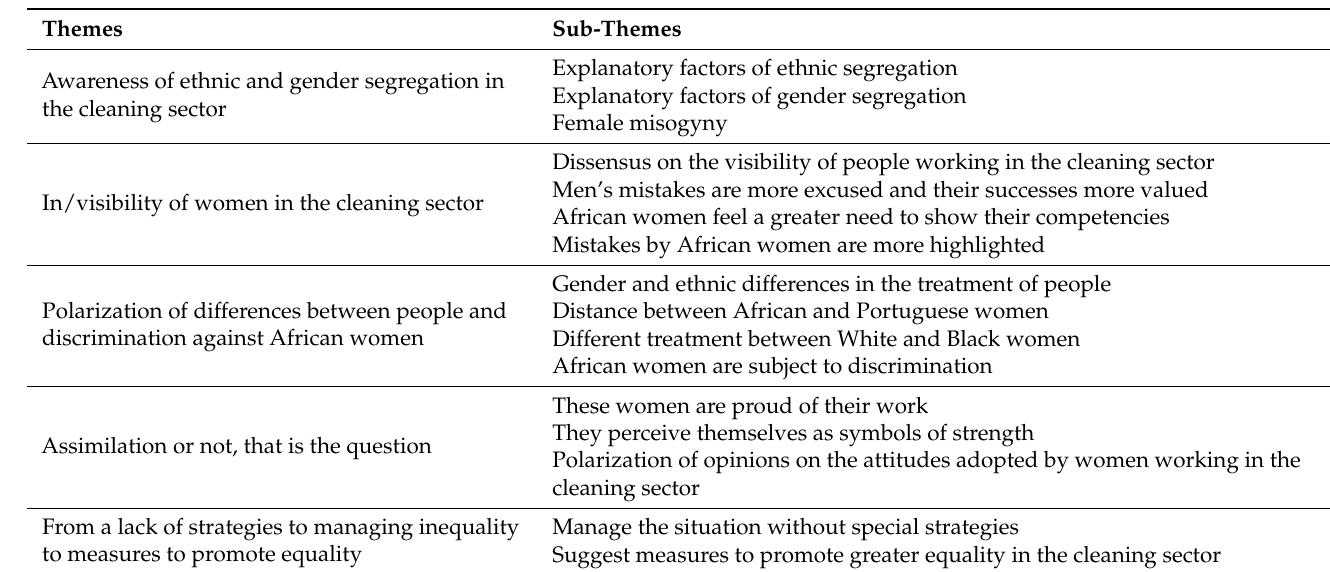
Table 2. Themes and